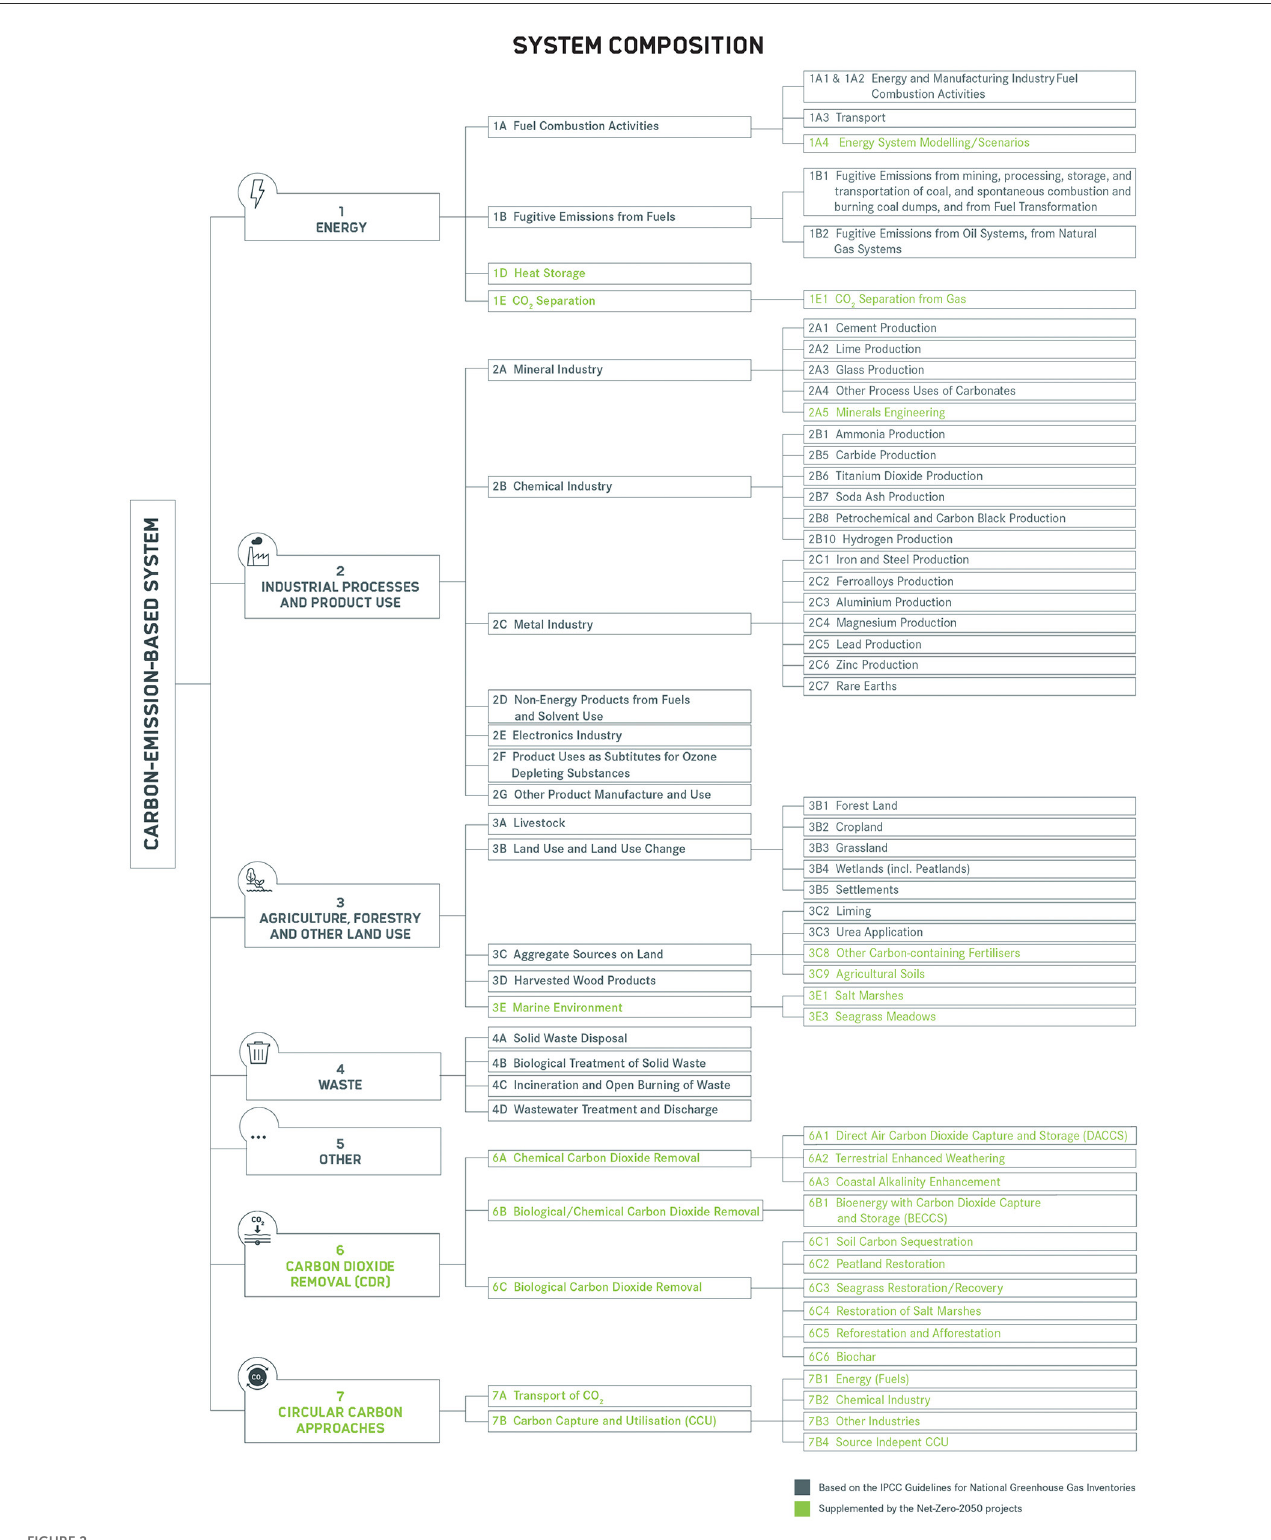
FIGURE2 Composition of the Net-Zero-2050 Carbon-Emission-Based System. The categories of the Carbon-Emission-Based System are divided into seven main categories with associated subcategories. Categories highlighted in gray are based on the IPCC’s categories and elements (2006, 2019). Categories marked in green were added or restructured and supplemented by Net-Zero-2050: The categories on CO 2 removal and circular carbon approaches (6 and 7) were rearranged or added as main categories incl.